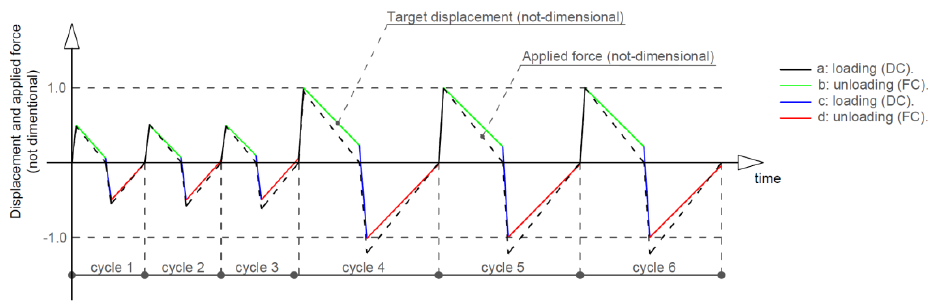
Figure 10. Multistep experimental procedure for preliminary tests (GFRP sample “1”).